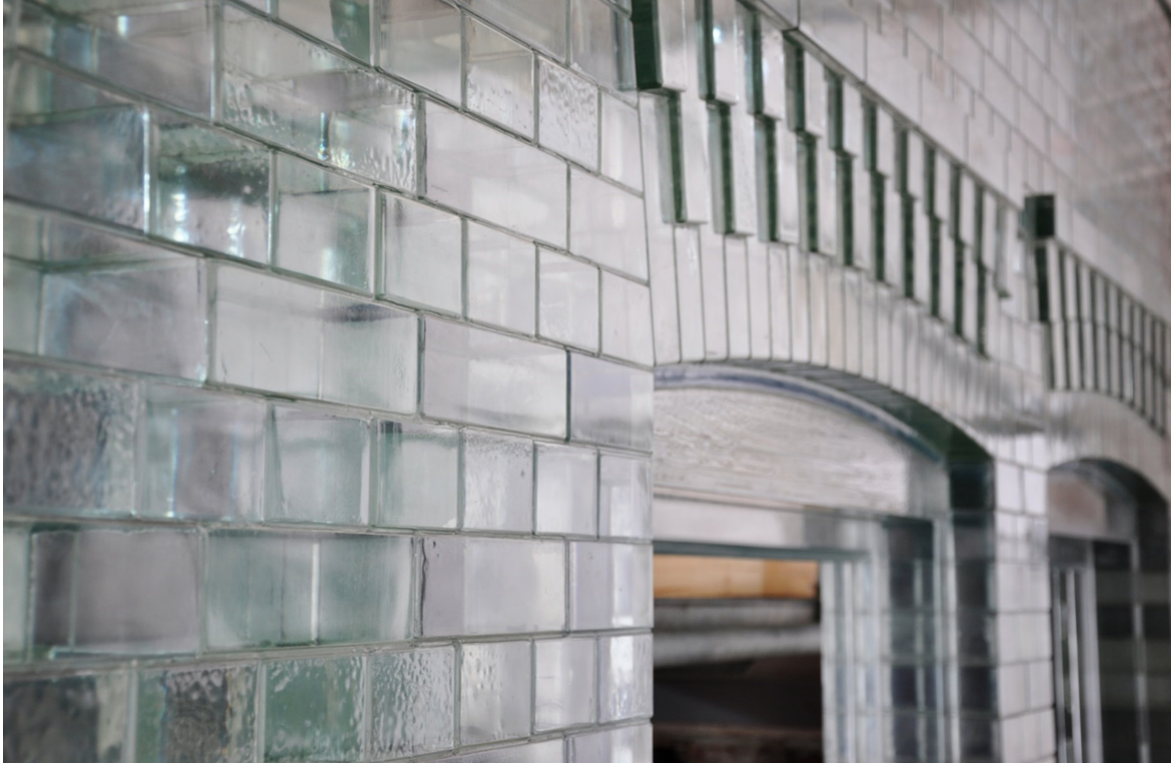
Fig. 14 Close up of glass masonry wall, the architraves and the cast glass window